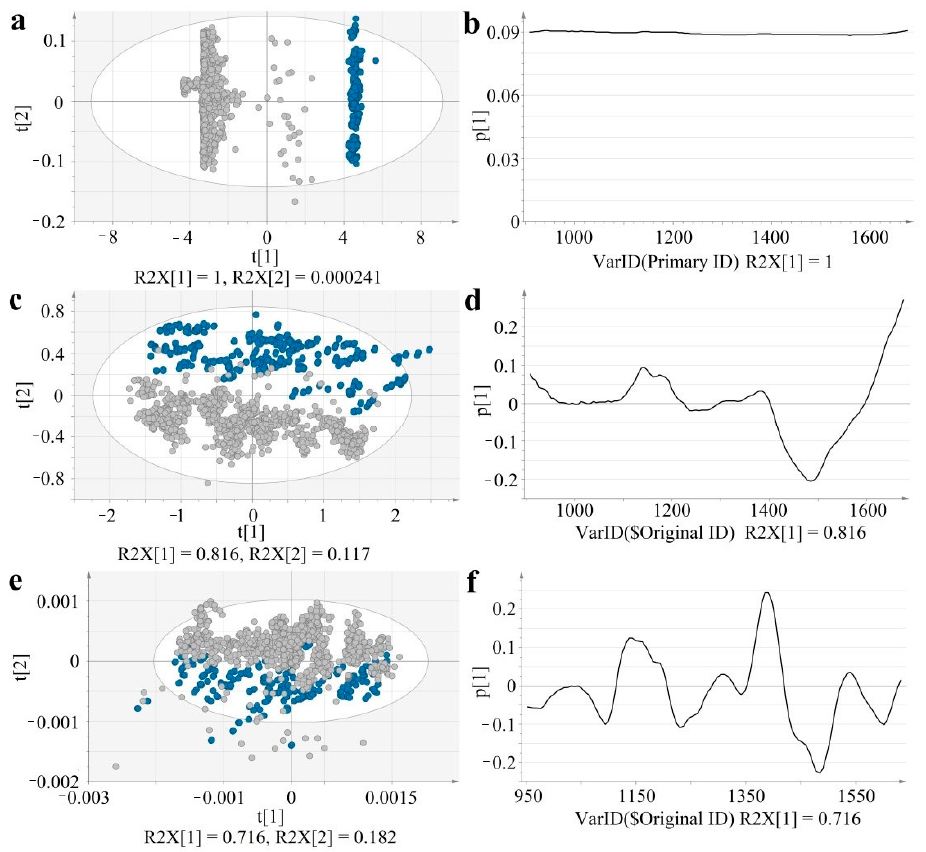
Figure 3. Score scatter and loading line plots of PCA models built on Raw ( a , b ), SNV ( c , d ), SD ( e , f ) processed at ‐ line and in ‐ line data (blue: at ‐ line data; grey: in ‐ line data).